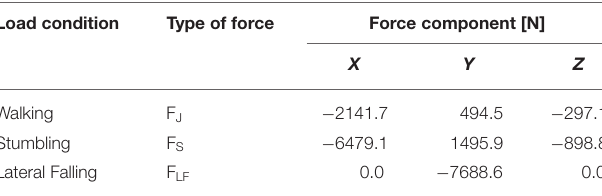
TABLE 3 | Simulated load conditions: walking (Bergmann et al., 2001), stumbling ( Bergmann et al., 2004), and lateral falling (Aldieri et al., 2018b). Load